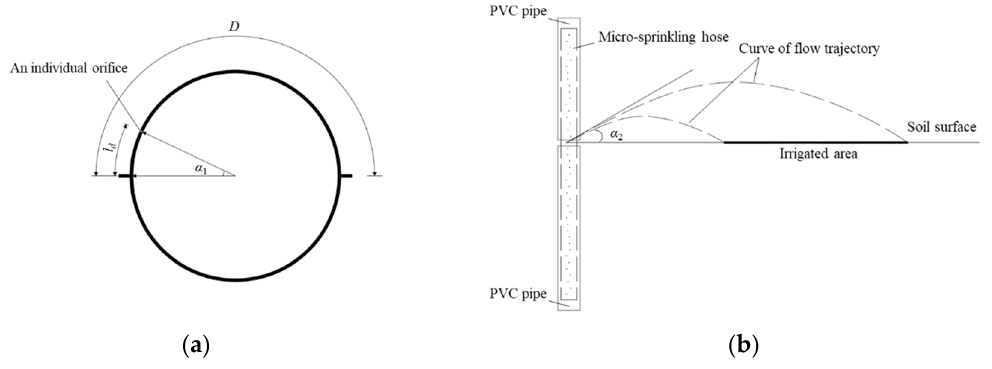
Figure 2. Schematic diagram of ( a ) orifice angle α 1 and ( b ) spraying angle α 2 of an individual